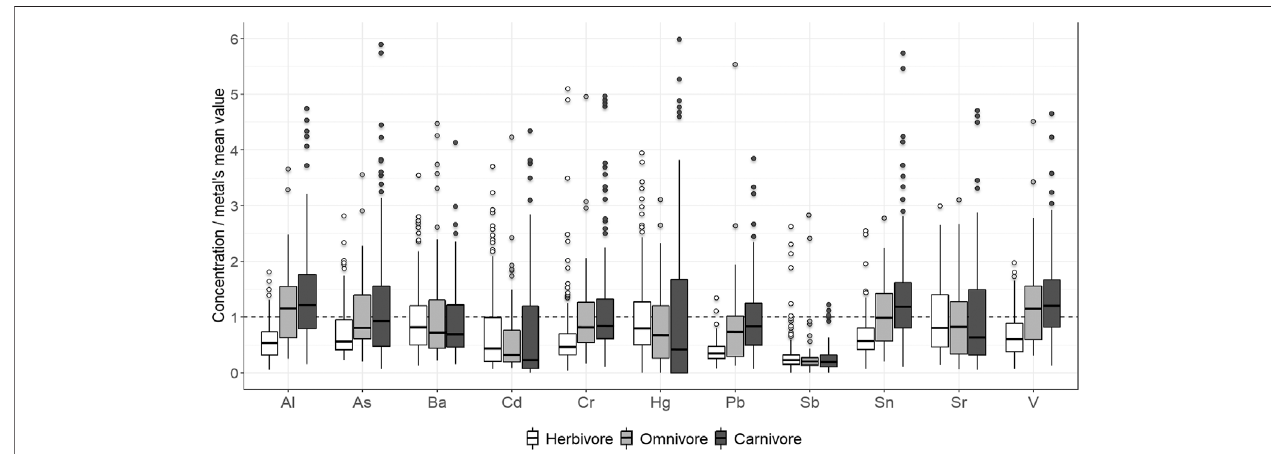
FIGURE2| Overallpro fi leofpotentiallytoxicelementconcentrationmeasuredinherbivorous(white),omnivorous(lightgrey),andcarnivorous(darkgrey)mammals relative to the mean for both sites (dashed line). Dark lines within boxes represent median values; the box represents the upper (3rd) and lower (1st) quartiles. Whiskers represent minimum and maximum values excluding outliers while points represent outliers. Concentrations are relativized and given as microgram per kilogram (µg/kg) faecal dry mass (DM).